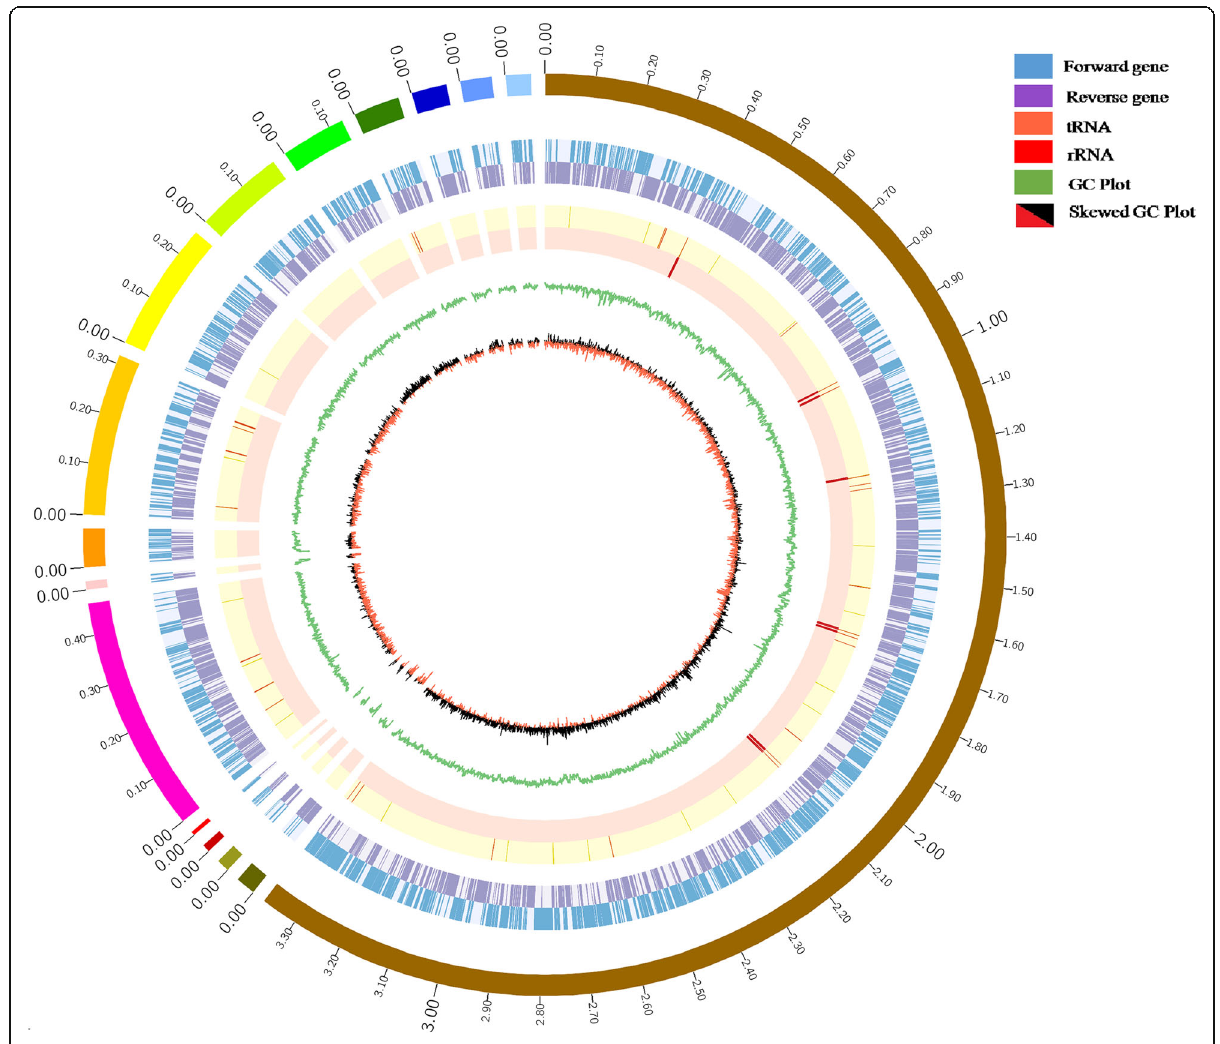
Fig. 4 A circular chromosomal map of the draft genome of strain J. lividum